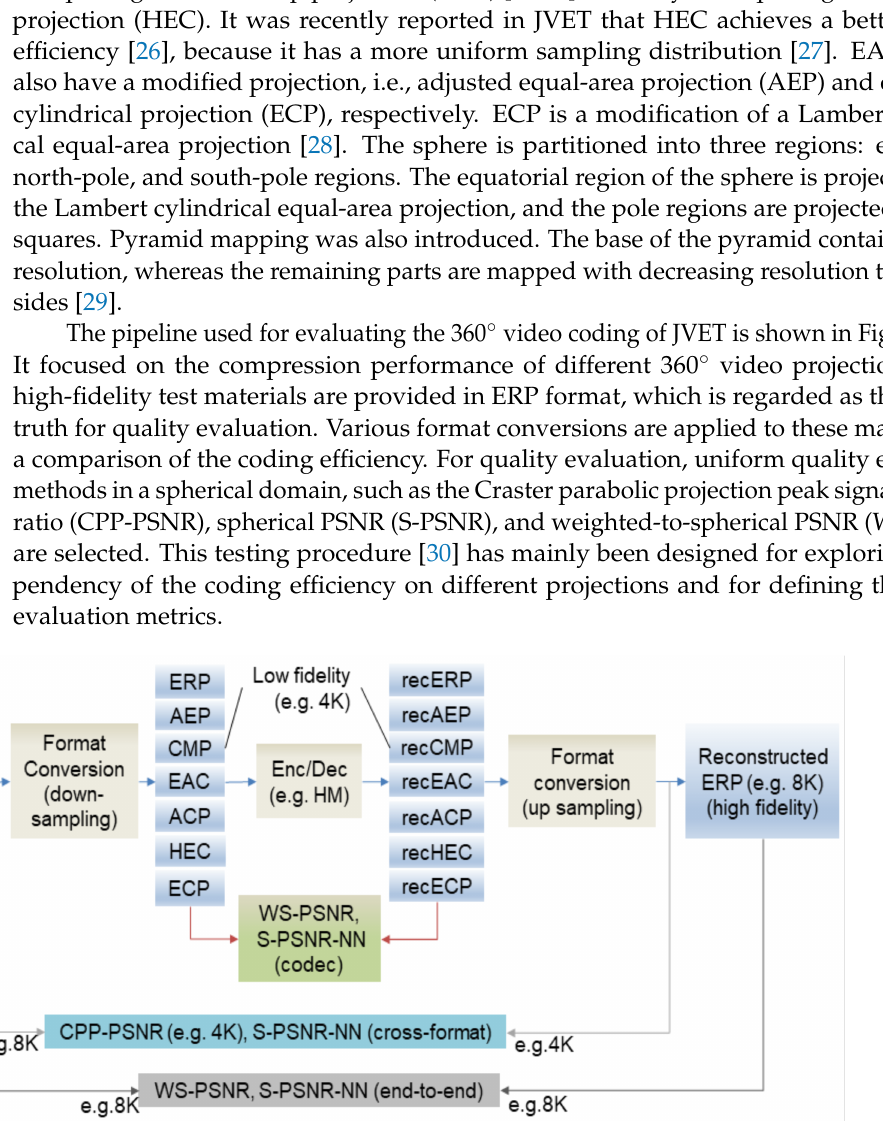
Figure 1. Pipeline for evaluating 360-degree video coding as recommended by JVET